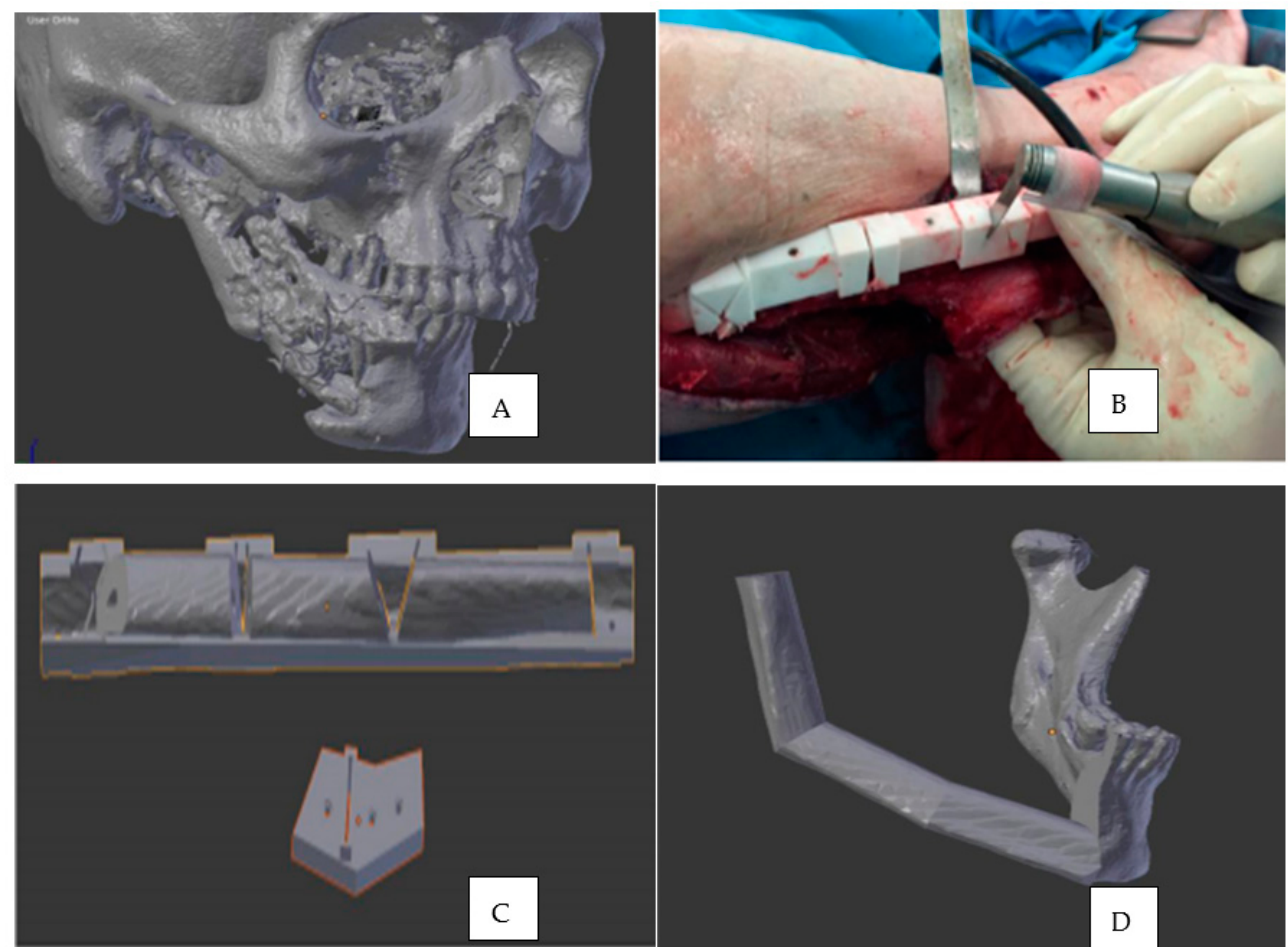
Figure 3. ( A ) CT of skull with osteoradionecrosis ( B ) 3D printed surgical guides used to guide osteotomies to obtain fibula from patient’s leg. ( C ) Surgical guide with harvested bone. ( D ) Surgical reconstruction of the jaws using scanning and 3D modelling. Image reprinted with permission from Ganry L et al. [99].